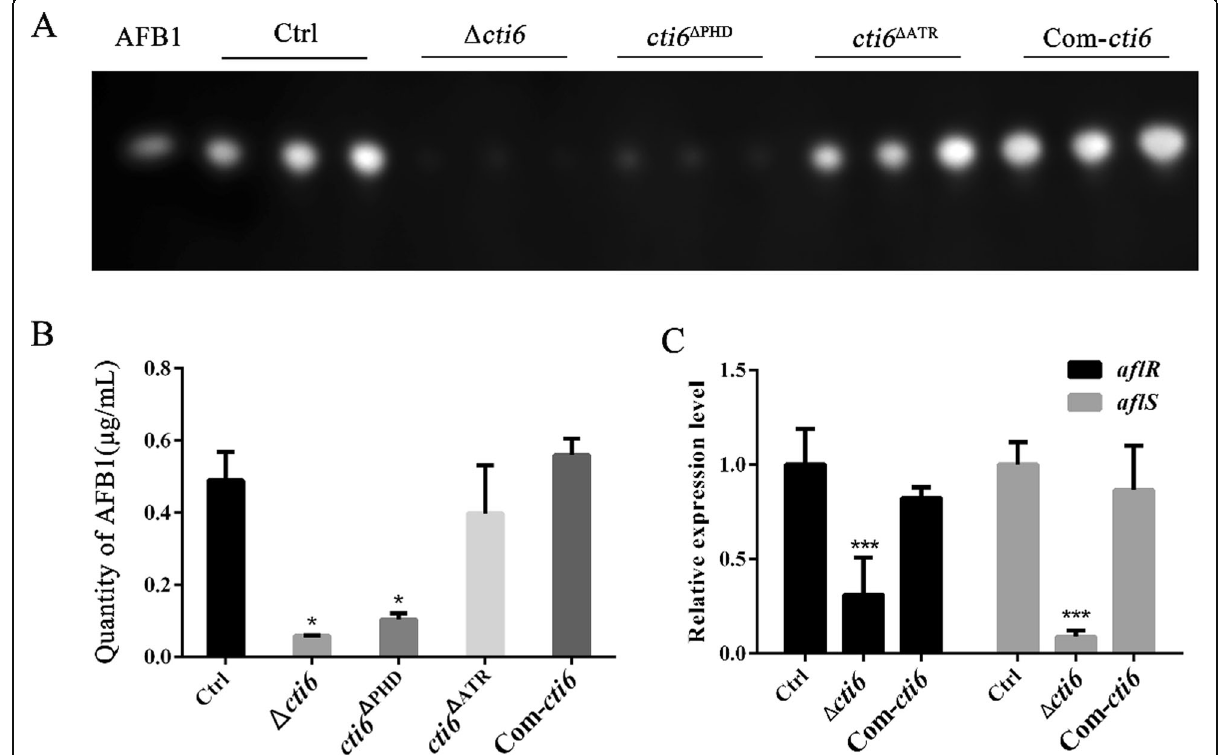
Fig. 4 Cti6 is critical in AFB1 synthesis in A. flavus . a The production of AFB1 from above fungal strains was analyzed with TLC. b The relative quantity of the amount of AFB1 according to the result from above TLC analysis. c The expression levels of AFB1 synthesis regulator gene aflR and aflS were analyzed by